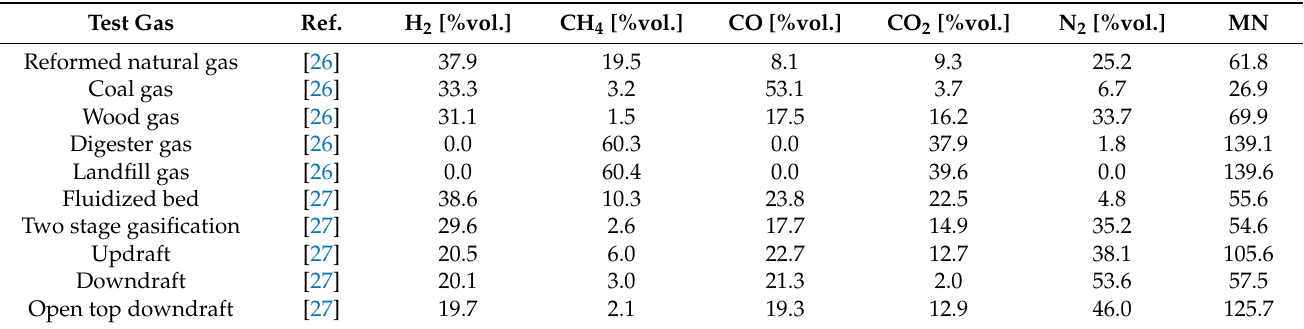
Table 4. Methane number of different synthesis gases adapted from Malenshek et al. [26] and Arunachalam et al. [27]. Test Gas